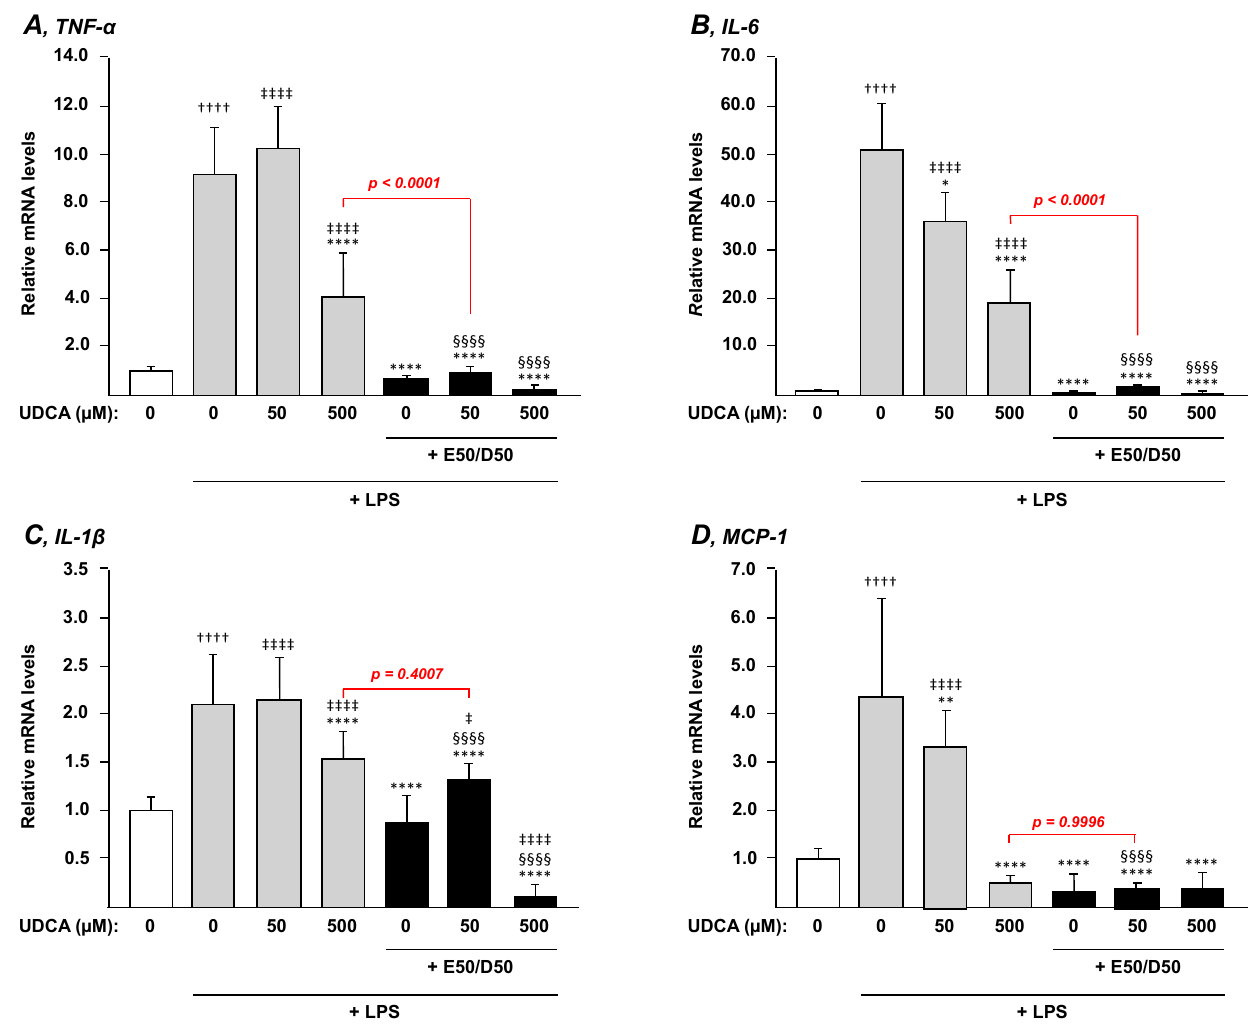
Figure 4. Addition of n-3 PUFAs to UDCA increases treatment anti-inflammatory potential in macrophages. THP-1 monocytes were differentiated into macrophages with PMA for 72 h and then stimulated with 100 ng/ µ L LPS for 24 h in the presence or absence of EPA/DHA, UDCA, or their combination as described in the materials and methods section. Total RNA was extracted. TNF- α ( A ), IL-6 ( B ), IL-1 β ( C ), and MCP-1 ( D ) transcript levels were quantified by qRT-PCR as detailed in the materials and methods section, and mRNA levels were expressed relatively to control cells (i.e., without LPS challenge) set at 1. Data represent the mean of 3 independent experiments in which each treatment was performed in triplicate. Each data point therefore corresponds to the mean of 9 replicates ± SD. Statistical significances as determined by a one-way ANOVA followed by Tukey’s multiple comparison post-hoc were as follows: Untreated differentiated THP-1 exposed to vehicle vs. untreated differentiated THP-1 exposed to LPS: †††† p < 0.0001; Vehicle differentiated THP-1 vs. UDCA treated differentiated THP-1: ‡‡‡‡ p < 0.0001; LPS exposed differentiated THP-1 vs. LPS + UDCA ± EPA/DHA exposed differentiated THP-1: * p < 0.05; ** p < 0.01; **** p < 0.0001; UDCA treated differentiated THP-1 vs. UDCA + EPA/DHA treated differentiated THP-1: §§§§ p <